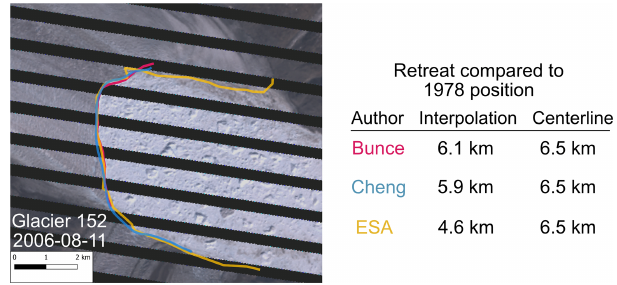
Figure 6. Terminus positions for Glacier 152 (Kangerlussuaq Glet- sjer) from 11 August 2006 for three authors. Bunce (pink) and Cheng (blue) traces end before the northern fjord wall, while the ESA (yellow) trace ends at the northern wall. The table shows each calculated retreat amount since the 1978 position using the interpo- lation method and the centerline method. Landsat-7 image courtesy of the U.S. Geological Survey. Base image has reduced saturation to increase contrast with